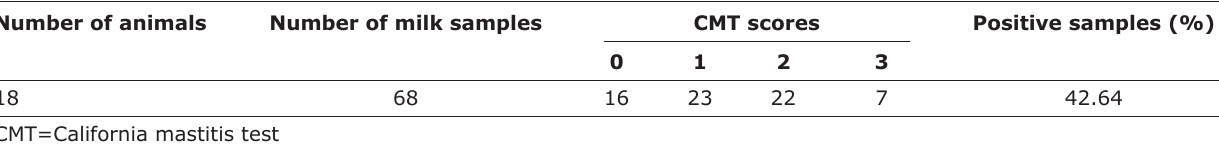
Table-1: Milk scores using CMT. Number of